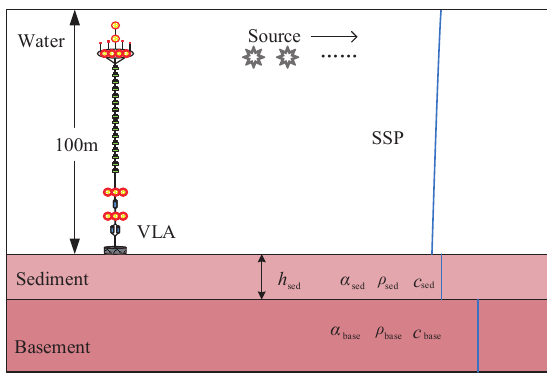
Figure 1. Geoacoustic environment model used in the sequential inversion